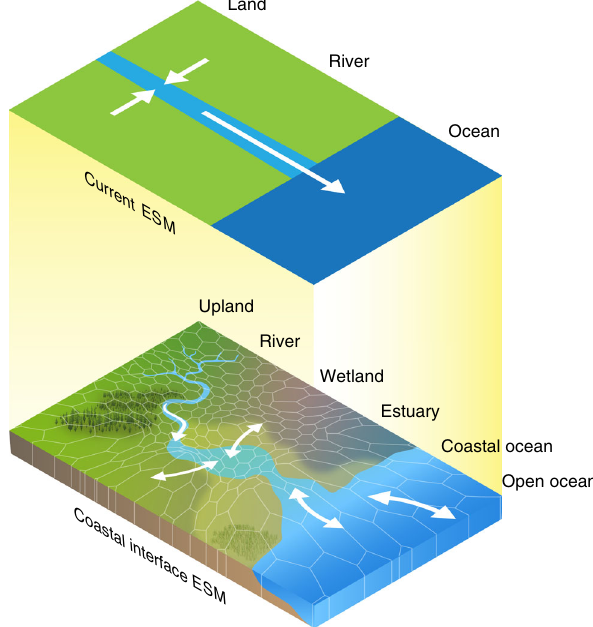
Fig. 1 Earth system model representation of the coastal interface. Current Earth system models (ESMs) represent the land and ocean as disconnected systems, with freshwater discharge being the only meaningful connection. Next-generation models should represent land – sea connections by incorporating coastal features such as the tidal rivers, wetlands, estuaries, the continental shelf, and tidal exchange across the coastal terrestrial – aquatic interface. This likely necessitates coupling different models to produce details at the sub-grid